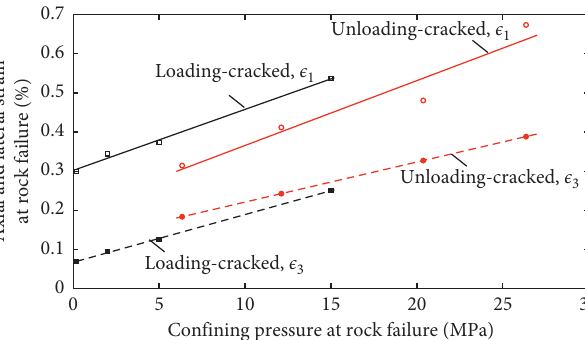
Figure 1: Variation of axial and lateral strain in loading and unloading tests.